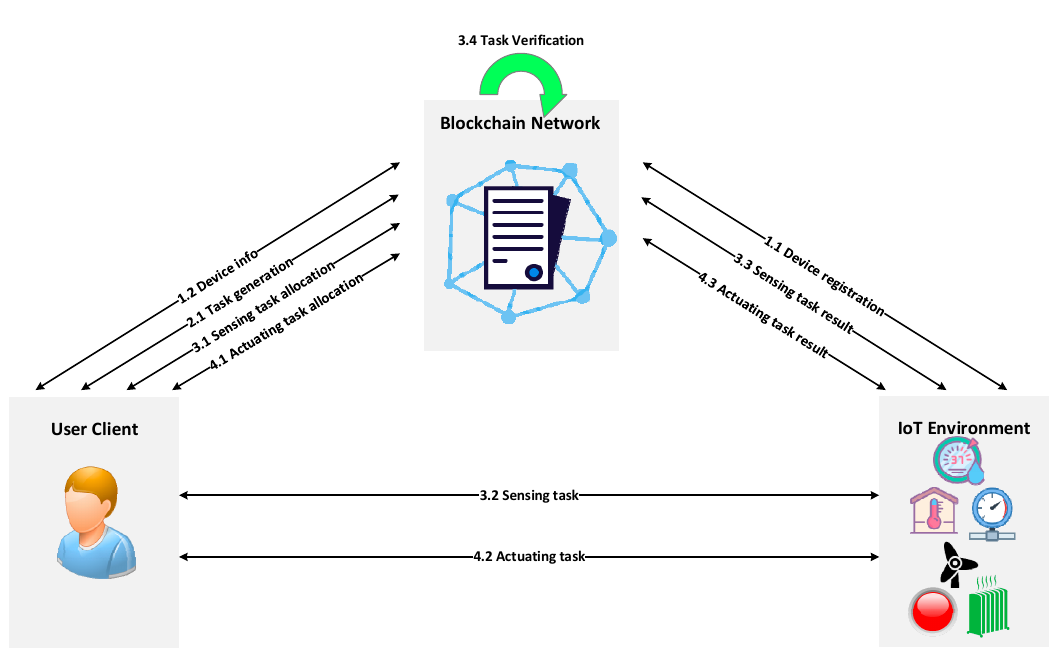
Figure 2. Service scenarios of the proposed system.